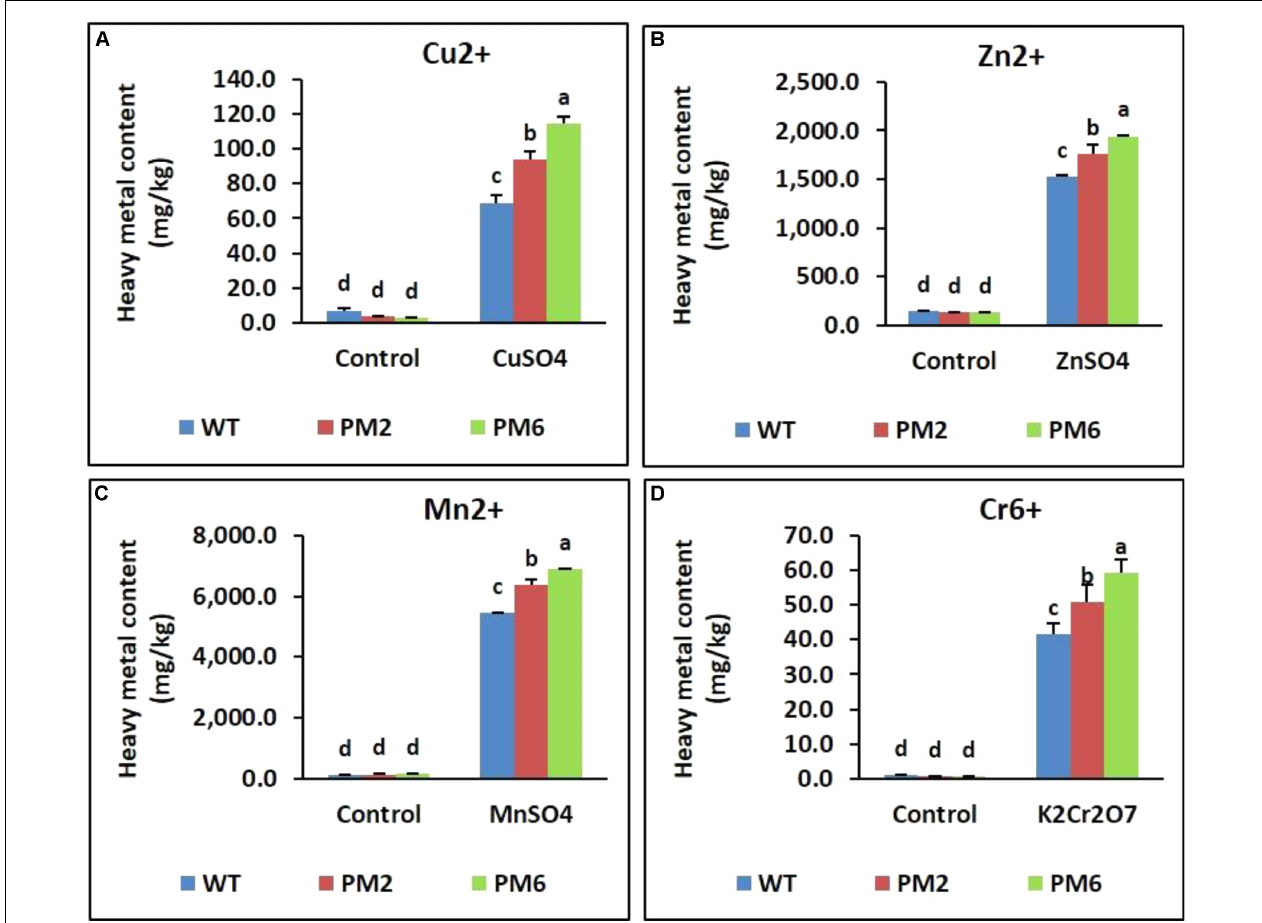
FIGURE 10 | Heavy metal content [Cu 2 + (A) , Zn 2 + (B) , Mn 2 + (C) , and Cr 6 + (D) ] accumulated in leaf tissue following heavy metal-stress treatment of the T 2 -PM6, T 2 -PM2, and WT plants. Data were taken on the thirtieth day after starting the experiments. Error bars indicate the